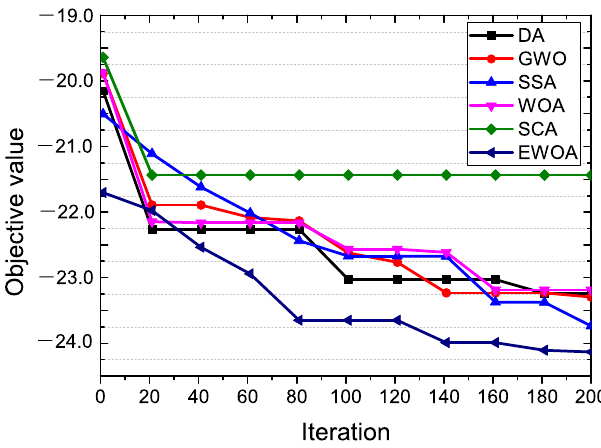
Figure 4. Convergence rates obtained by different algorithms.